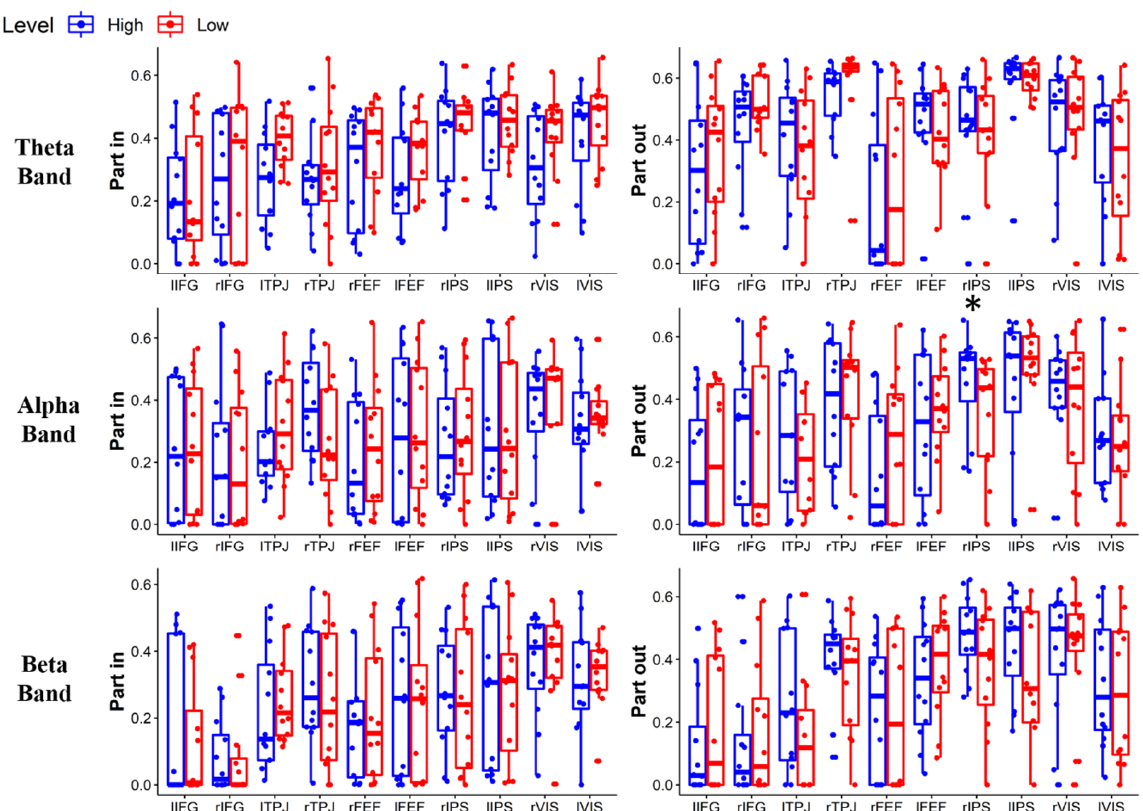
Figure 8. Wilcoxon test between Low and High attentional demand of the participation in ( Left ) and the participation out ( Right ) indexes for each ROI and band ( rows ). The single asterisk (*) means p < 0.01064 (FDR corrected).